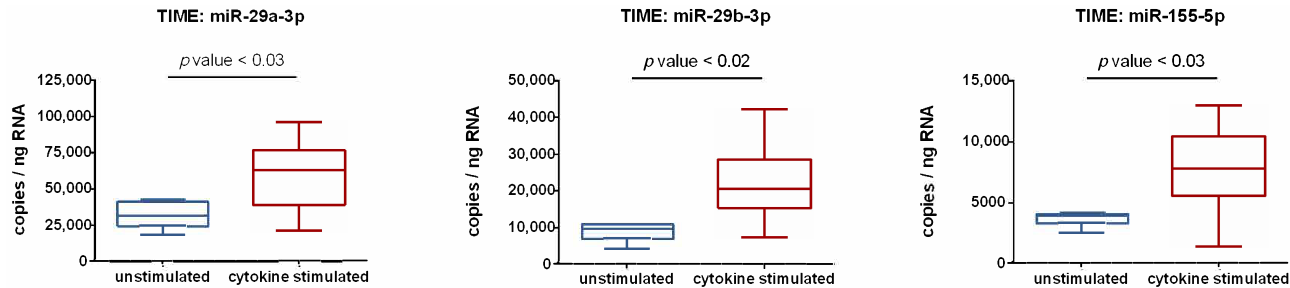
Figure 3. Human endothelial cells (cell line TIME, ATCC ® number CRL-4025) were evaluated following stimulation with 5 ng/mL each of IL-1 β , TNF- α , and IFN- γ for 24 h, and compared to unstimulated controls. Absolute quantification of miRNAs from isolated total RNA was performed using ddPCR analysis. The QX 200 Droplet Digital PCR System (Bio-Rad) and specific LNA PCR primers (Qiagen) were used according to the manufacturer’s instructions. Based on the number of measured positive droplets, the system calculates the copy number of the target RNA in the total mixture, assuming a Poisson distribution. Since a defined amount of RNA sample is used in each ddPCR assay, the copy number per ng RNA can be determined. The box plots depict the median of determined miRNA expression levels, the lower and upper quantile, and the two extreme values. Each group included six biological replicates and two technical replicates. An unpaired t-test was used to identify significant differences. Statistical analysis was performed utilizing GraphPad Prism 9 (GaphPad Software, La Jolla, CA, USA). In all cases, p < 0.05 was assumed to indicate significant